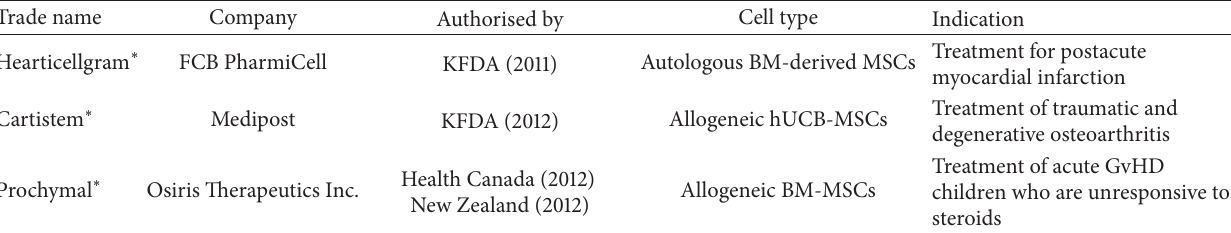
Table 3: MSC cell-based therapies with a valid marketing